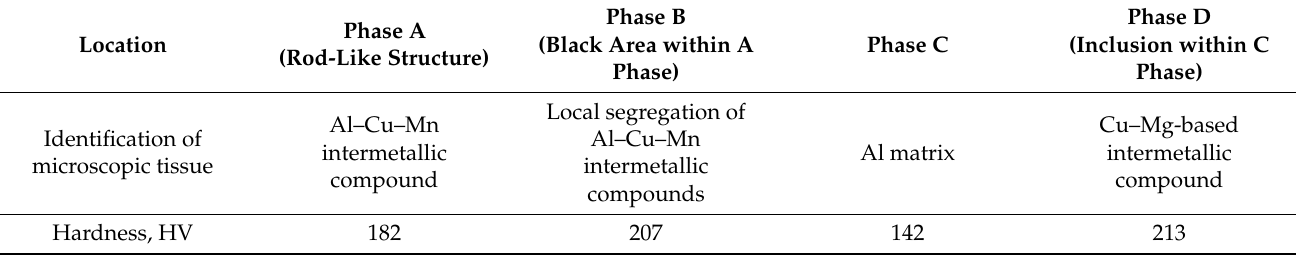
Table 3. Results of microscopic tissue identification and microhardness